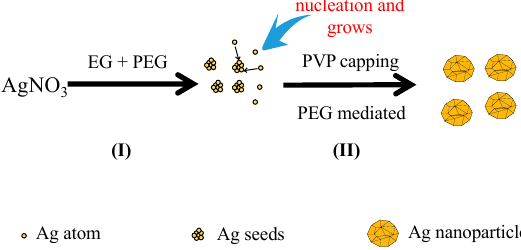
Figure 6. Schematic illustration of formation of uniformity Ag nanoparticles in mixed solvents of EG and PEG.